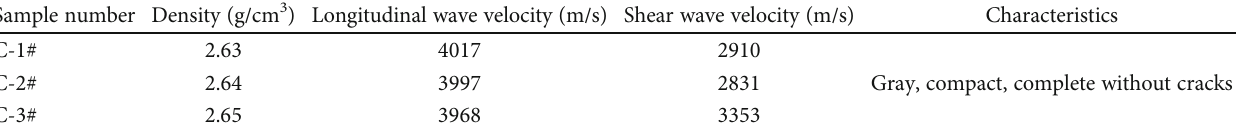
Table 2: Basic physical parameters and characteristics of granite samples.